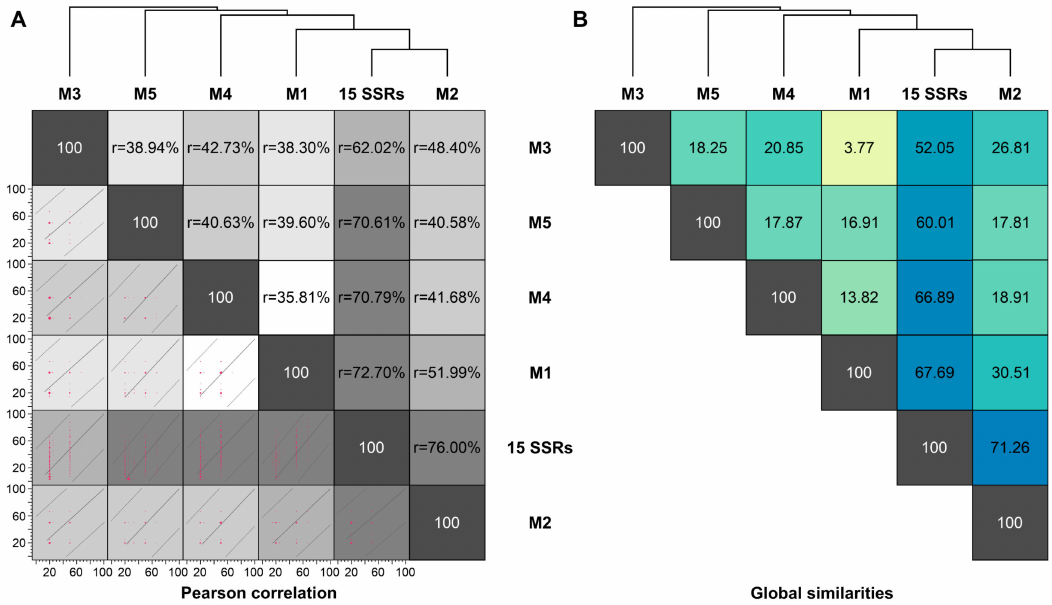
Figure 7. Pairwise congruence between experiments (multiplexes): ( A ) Pearson correlation between experiments evaluated for 180 Sporothrix isolates is displayed above the diagonal, and correlation plots are depicted below the diagonal. ( B ) A similarity index was calculated in BioNumerics v7.6, comparing M1–M5 and the complete